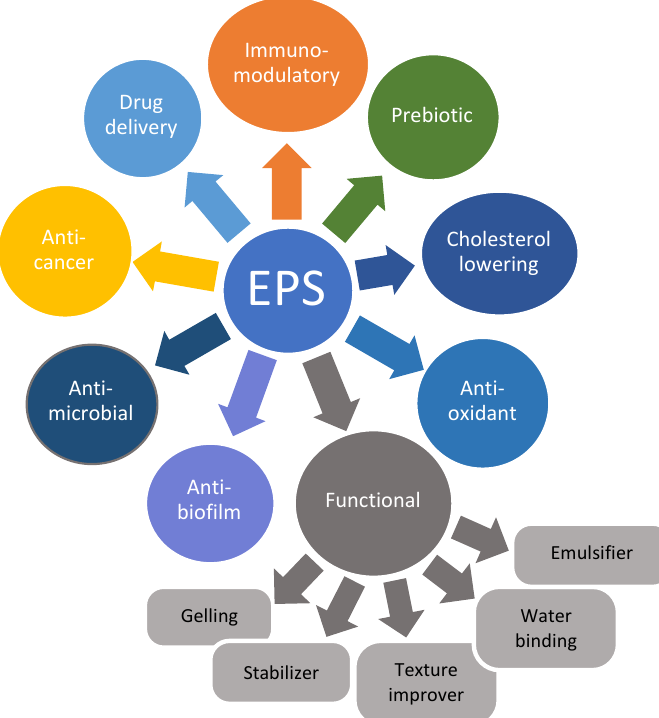
Figure 3. Biological and functional activities exerted by EPS produced by LAB.